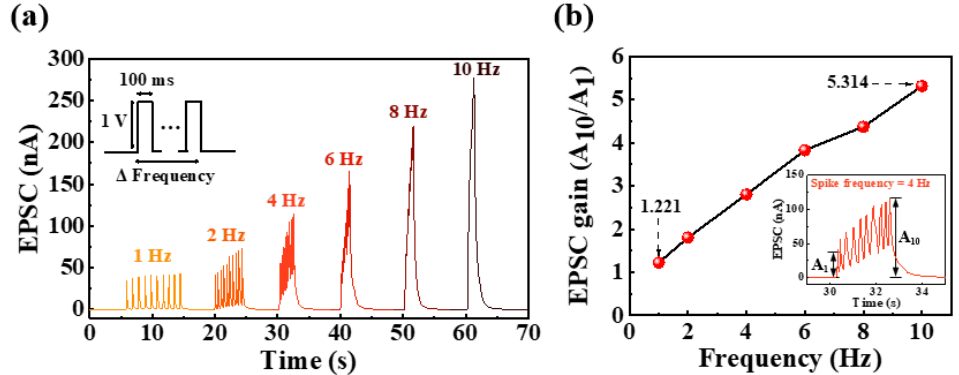
Figure 5. ( a ) EPSCs by applying ten consecutive pre-synaptic spikes with different frequencies and ( b ) EPSC gain (A 10/ A 1 ) according to different applied spike frequencies.